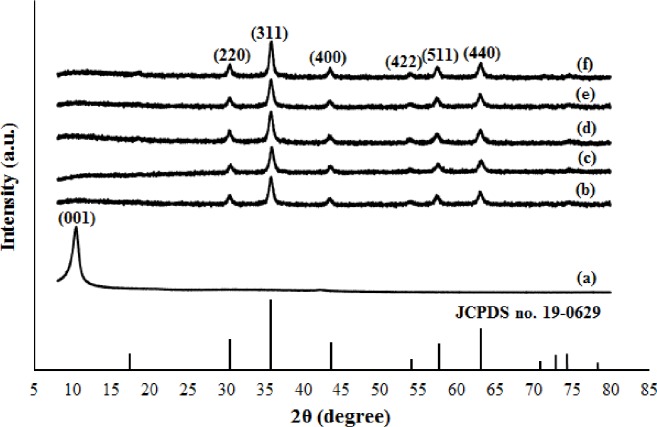
XRD patterns of (a) GO, (b) M-rGO3, (c) M-rGO6, (d) M-rGO12, (e) M-rGO18, (f) M-rGO24 and the reference data for Fe3O4 of JCPDS no. 16–0629.